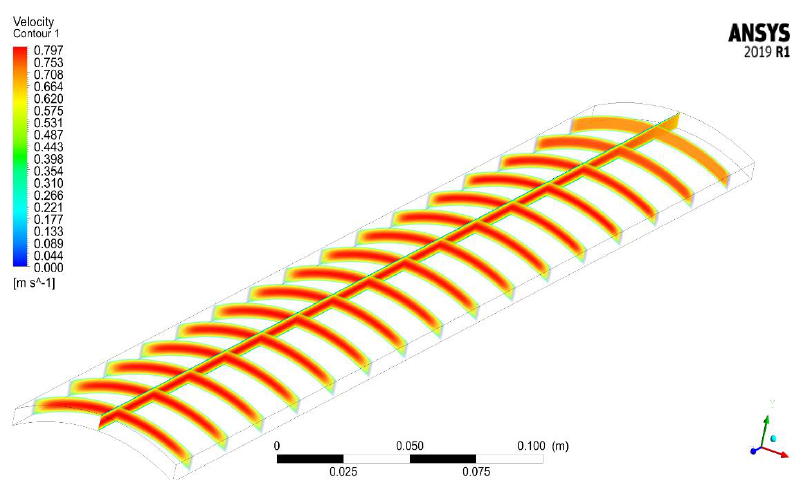
Figure 16. Temperature contours for the convex side of Clad.